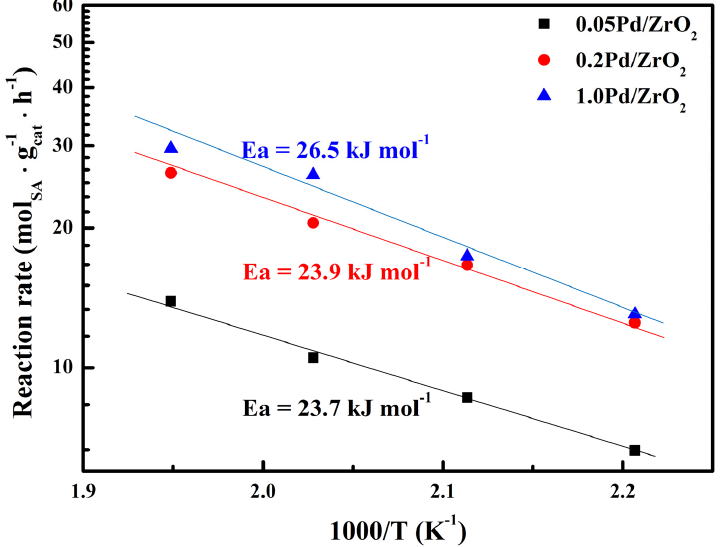
Figure 3. Arrhenius plots of reaction rates over Pd/ZrO 2 catalysts with different Pd loadings.